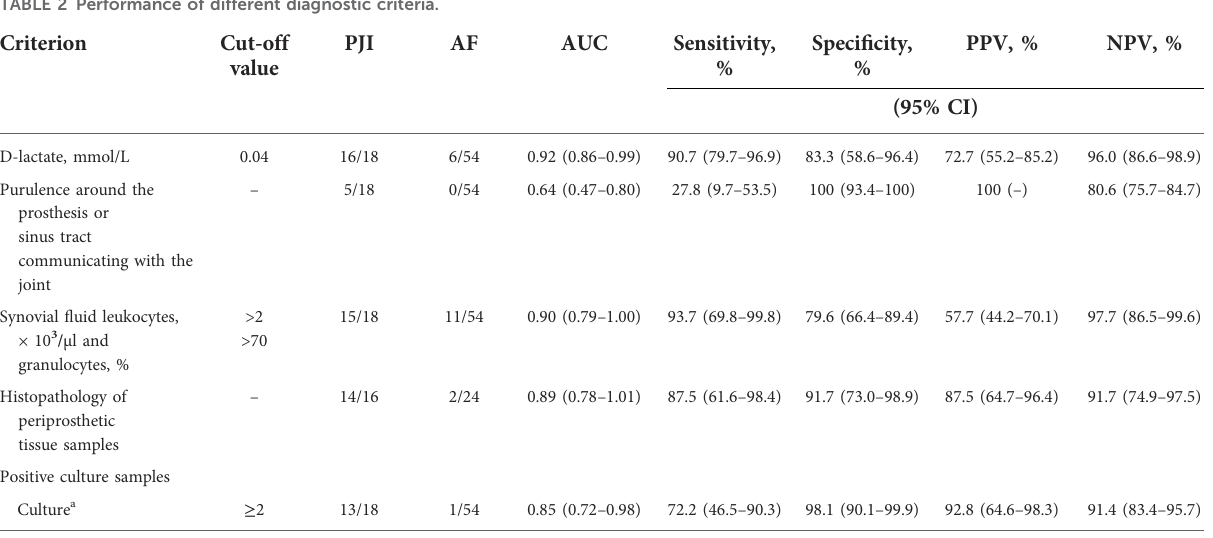
TABLE 2 Performance of different diagnostic